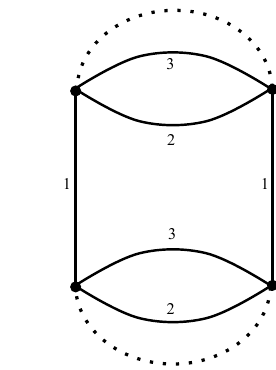
Figure 1 . Graphical representation of the interaction vertices (GN and pillow).